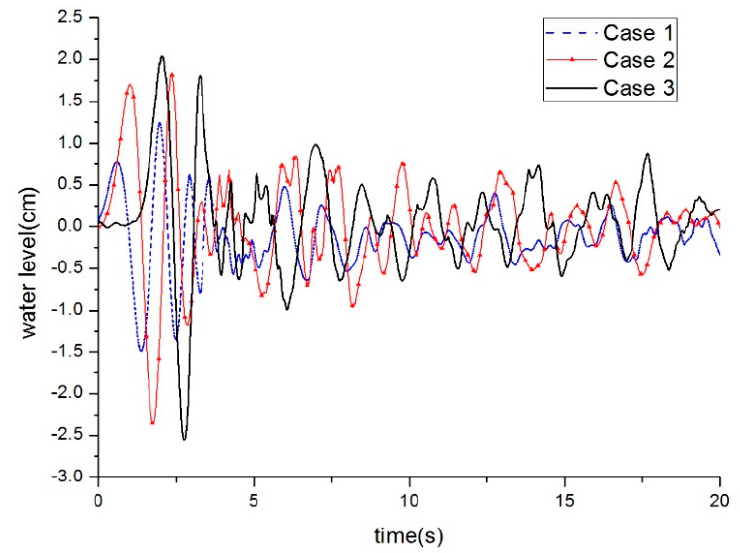
Figure 13. Variation curve of the water level at point 2 with different thickness values.